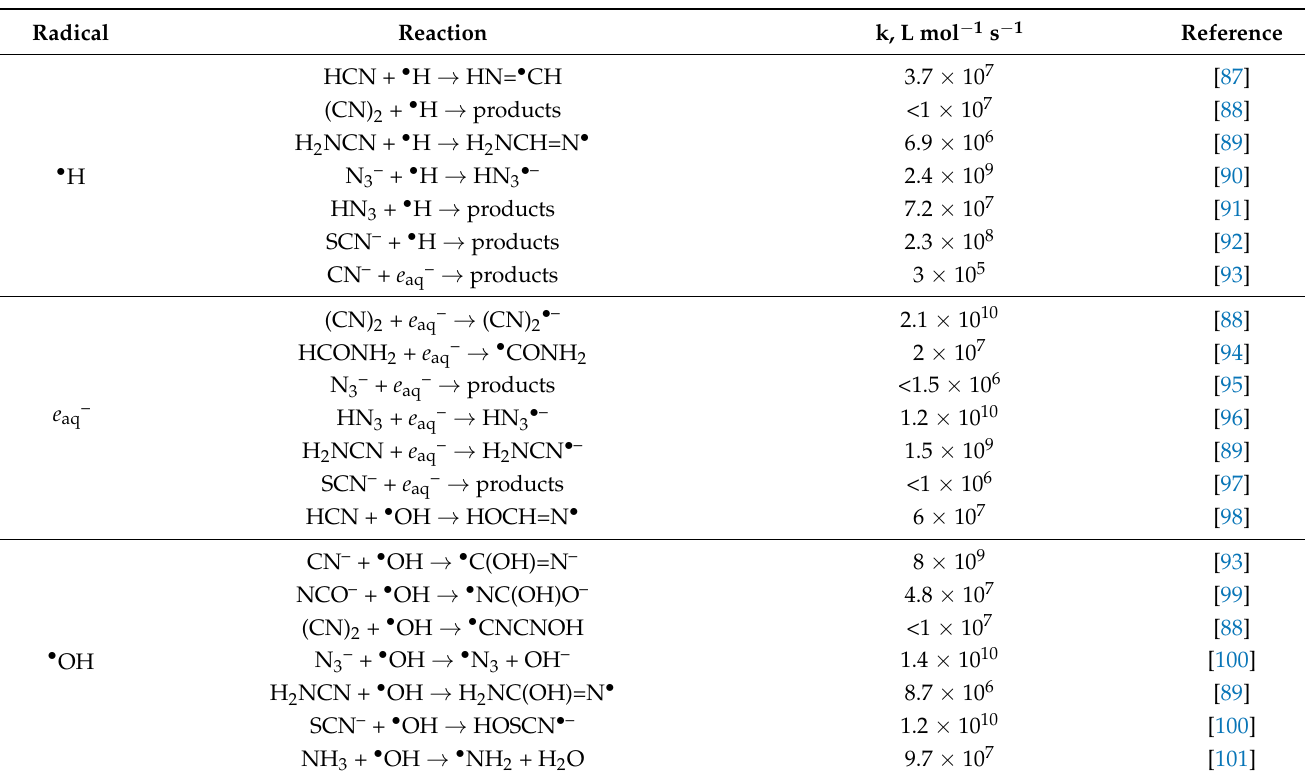
Table 2. Rate constants of e aq– , • H, and • OH with carbon- and nitrogen-containing compounds. Radical